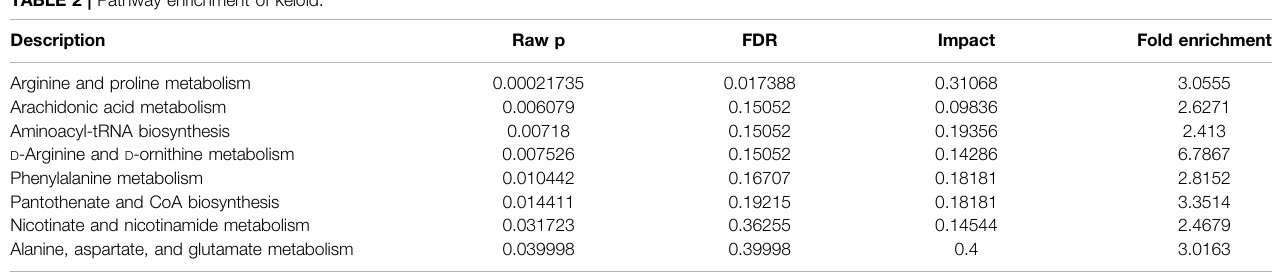
TABLE 2 | Pathway enrichment of keloid.